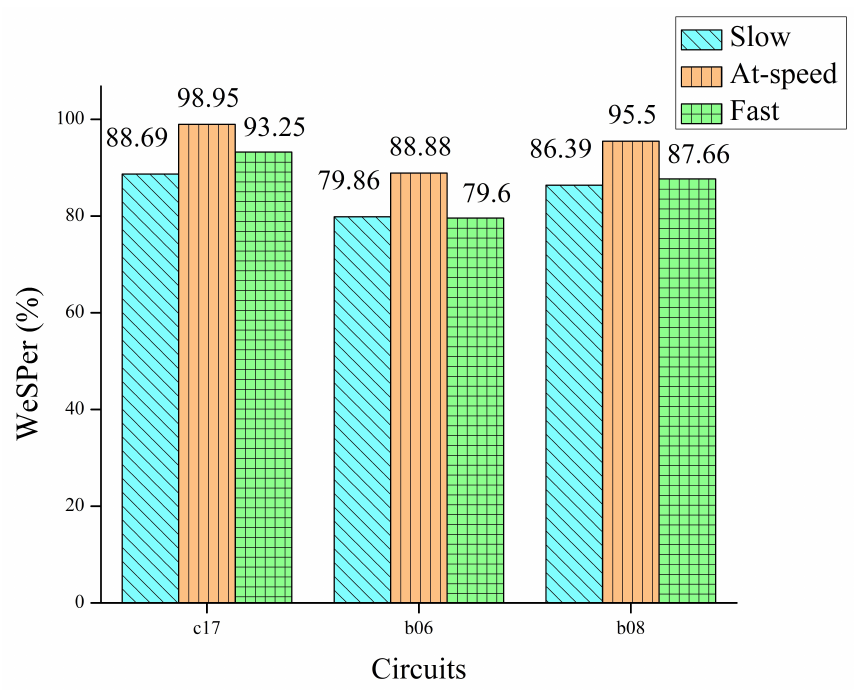
Figure 15. Comparison of WeSPer percentage for Slow, At-speed and Fast test clocks for three different benchmark circuits [84].